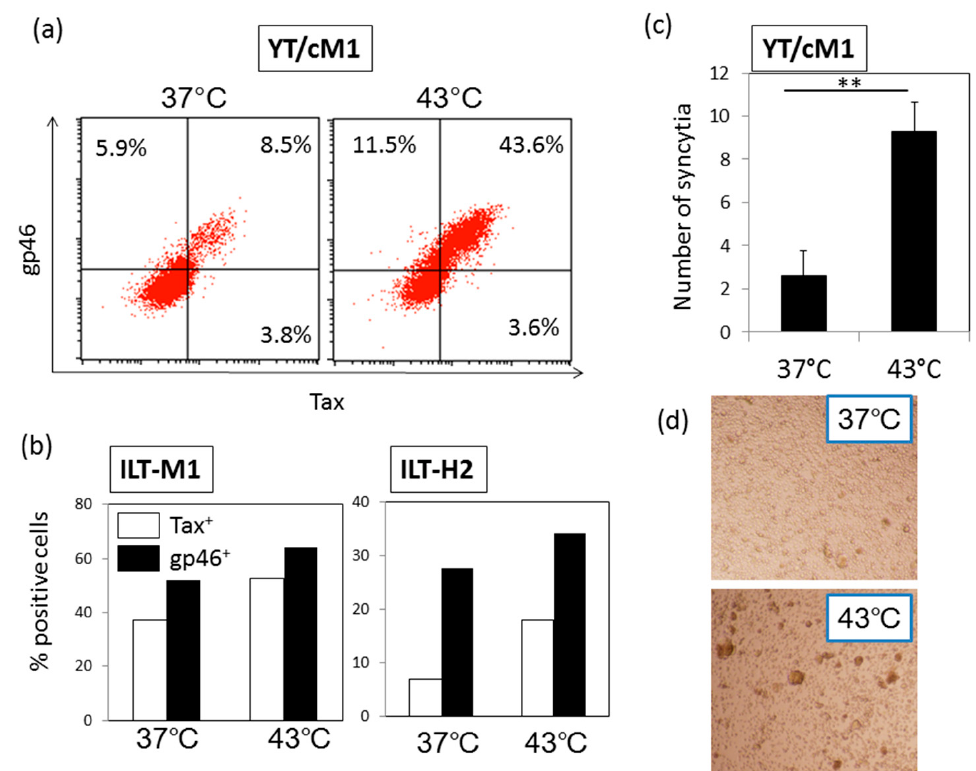
Figure 3. Enhancement of HTLV-I envelope gp46 expression by HS: Three HTLV-I-producing T cell lines CD4 + YT/cM1, an HTLV-I associated myelopathy/tropical spastic paraparesis (HAM/TSP)-derived CD8 + ILT-M1 and an ATL-derived CD4 + ILT-H2, were either exposed to HS or mock treated and cultured for 24 h. ( a , b ) The levels of gp46 along with Tax antigen expression were determined by FCM. Data shown are representative of three independent experiments. ( c ) Syncytium formation capacity was compared between untreated and heat shocked YT/cM1 cells by a co-culture method using Jurkat cells as the indicator cell line. The numbers of syncytia were counted in triplicate cultures and the means (cid:8) SD are shown. ** p < 0.01. ( d ) Syncytia formed in each culture were microscopically